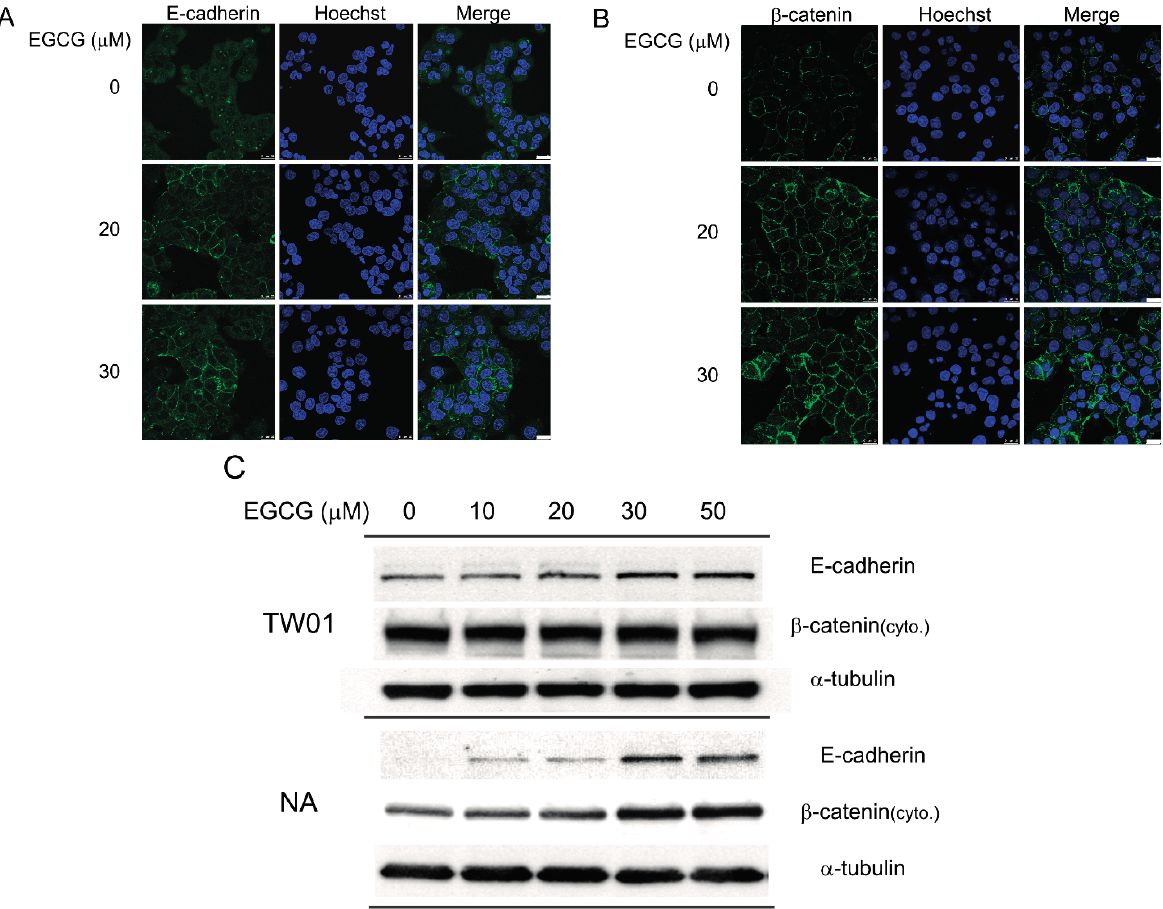
Figure 3. EGCG up-regulates the expression of cell adhesion molecules. NPC cells were treated with various concentrations of EGCG for 24 h. ( A ) The expression of E-cadherin was revealed by confocal microscopy in NA cells. Cell nuclei were stained with Hoechst 33258. The white bar at the lower corner represents a length of 25 μ m; ( B ) The expression of β -catenin was determined by confocal microscopy in NA cells. Cell nuclei were stained with Hoechst 33258. The white bar at the lower corner represents a length of 25 μ m; ( C ) Western blot analysis of E-cadherin and cytoplasmic β -catenin expression at 24 h in NPC cells. α -tubulin is detected as a loading